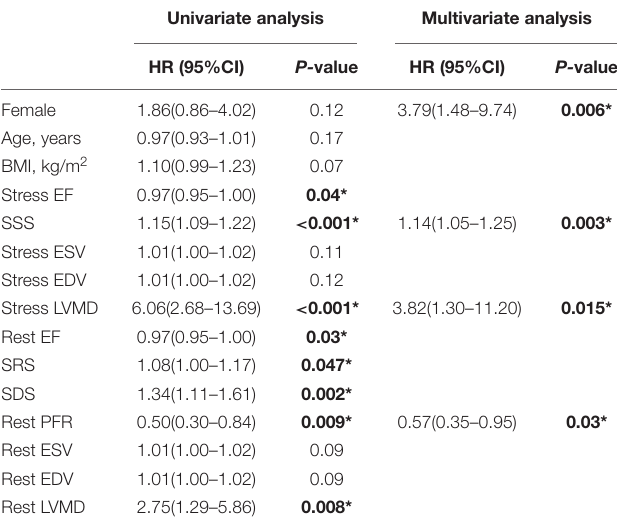
TABLE 5 | Univariate and multivariate cox regression analysis for predicting MACEs. Univariate